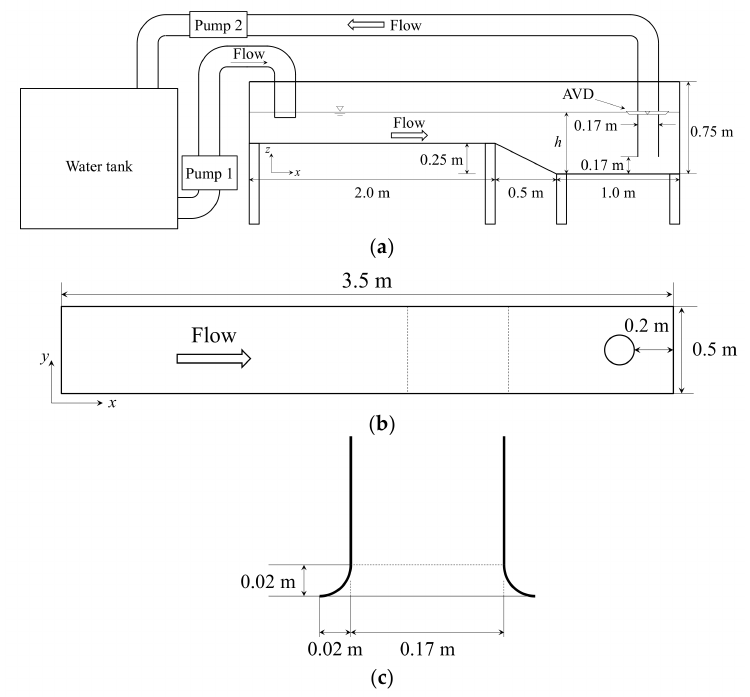
Figure 2. Conceptual diagram of the laboratory channel: ( a ) side view; ( b ) plan view; and ( c ) shape of the bell